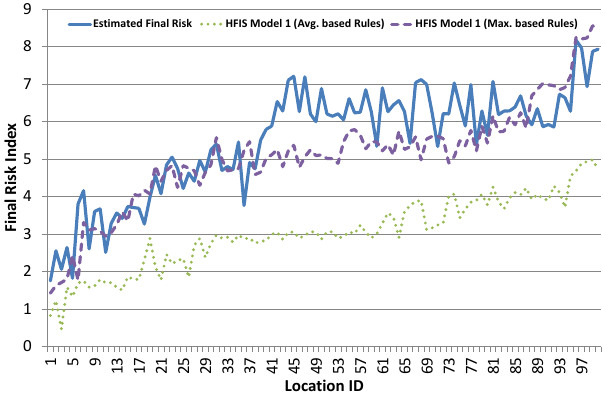
Figure 10. Results of basic hierarchical FIS Model 1.